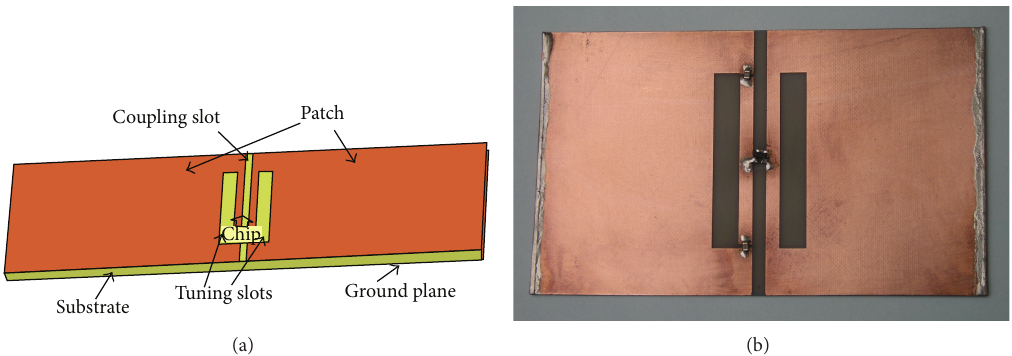
Figure 10: Sketch and photograph of the directly excited coupled shorted-patches antenna with tuning slots.